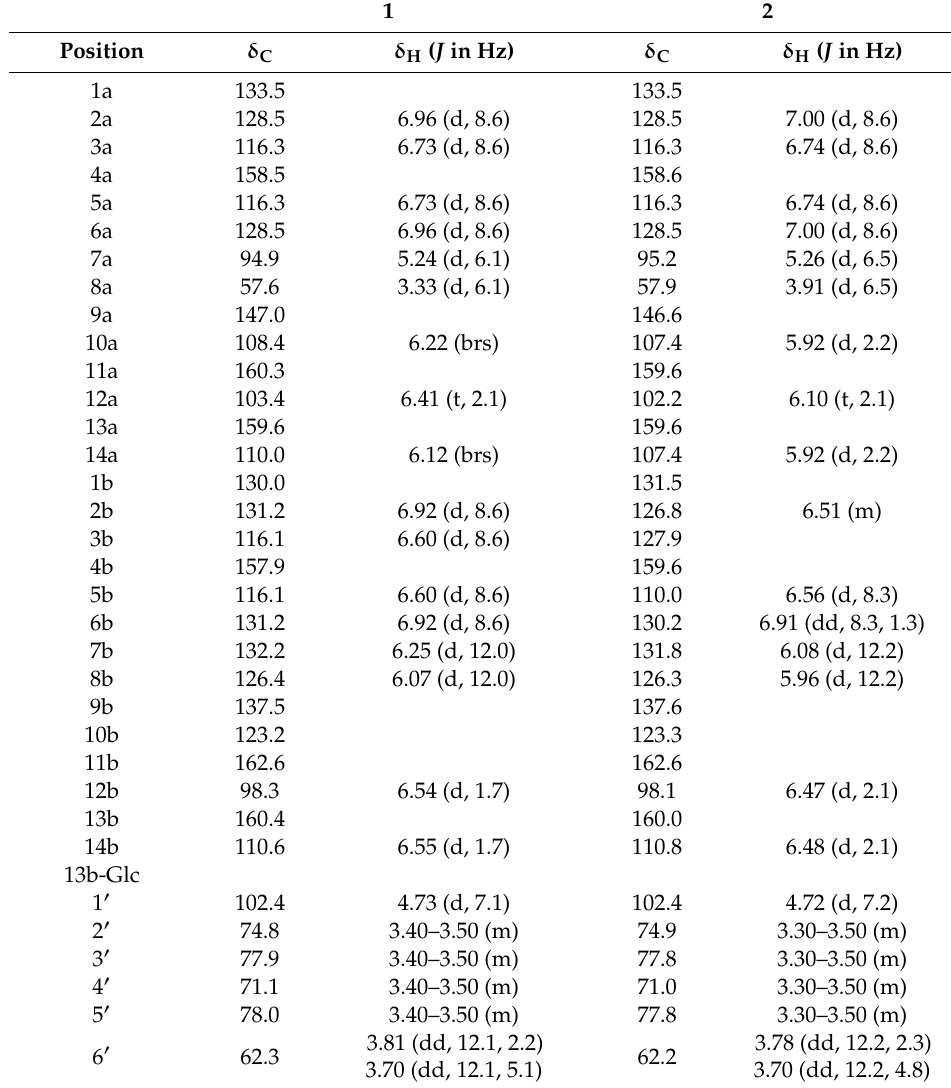
Table 2. 1 H- (600 MHz) and 13 C-NMR (150 MHz) spectroscopic data of compounds 1 and 2 in MeOH- d 4. 1 2 Position δ C δ H ( J in